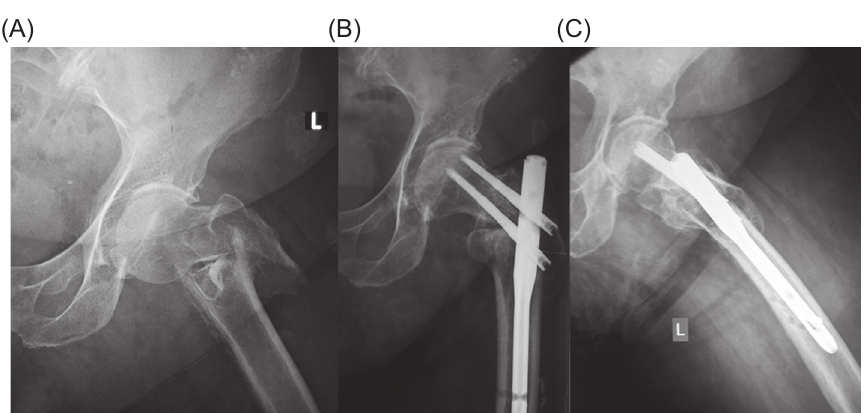
Figure 3. (A) Anteroposterior radiograph of the left hip of an 81-year-old woman shows an AO/OTA-31-A3 fracture. (B) Anteroposterior and (C) lateral radiographs of the left hip one year after surgical treatment show fracture healing. The patient was alive with good function.